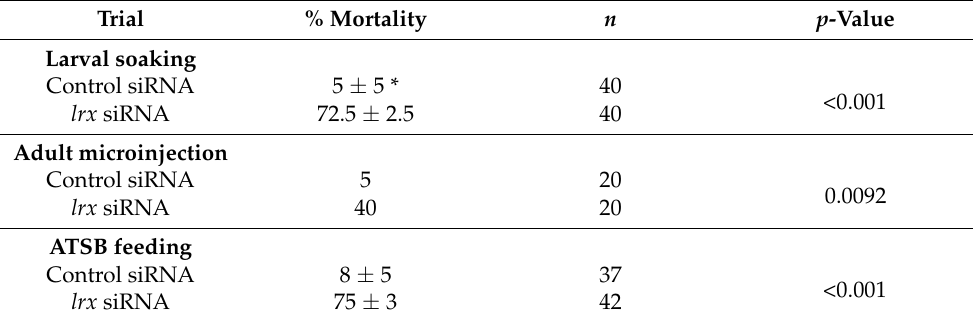
Table 1. Irx .447 siRNA treatments result in Aedes aegypti larval and adult mortality.